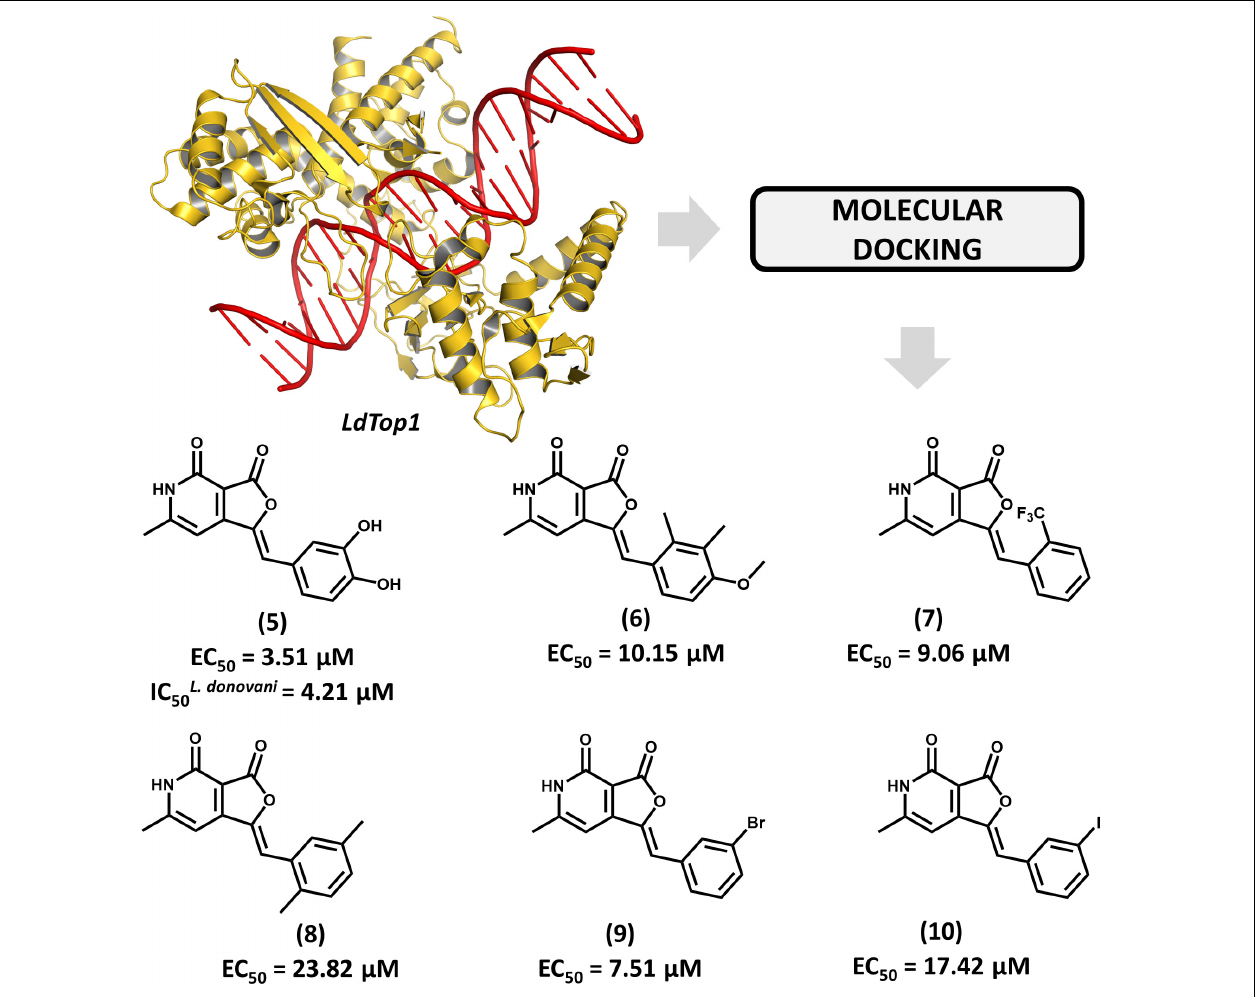
FIGURE 4 | Structure-based drug design approach to the discovery of a series of L. donovani topoisomerase 1 ( Ld Top1) inhibitors. The strategy employing molecular docking led to the identification of compound 5 which shows suitable in vitro antiparasitic activity.